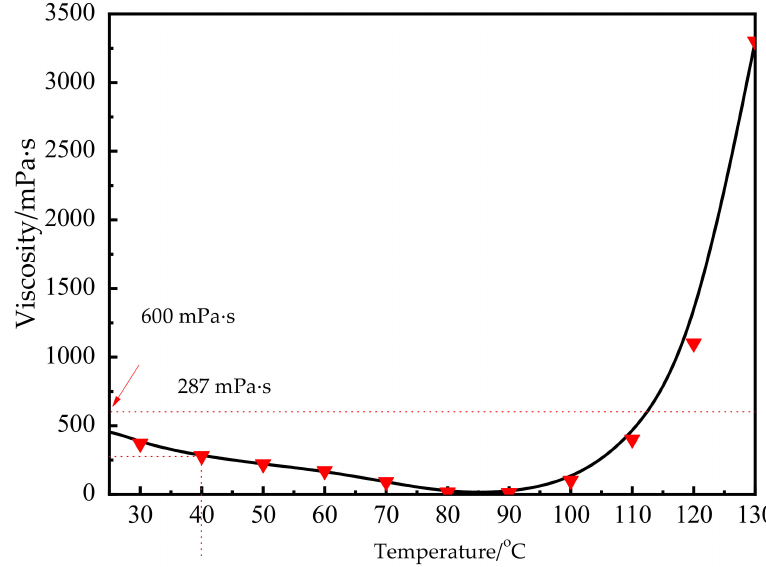
Figure 5. Viscosity variations of X4302A/B resin system with